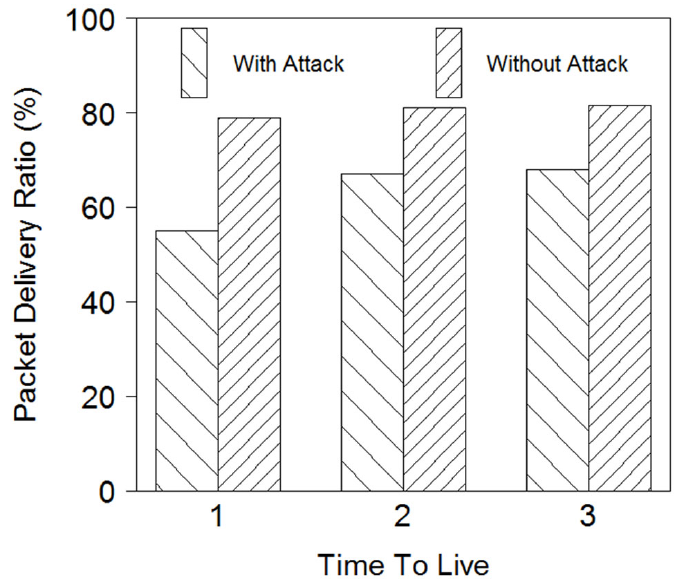
Figure 10. Time to live vs. PDR.